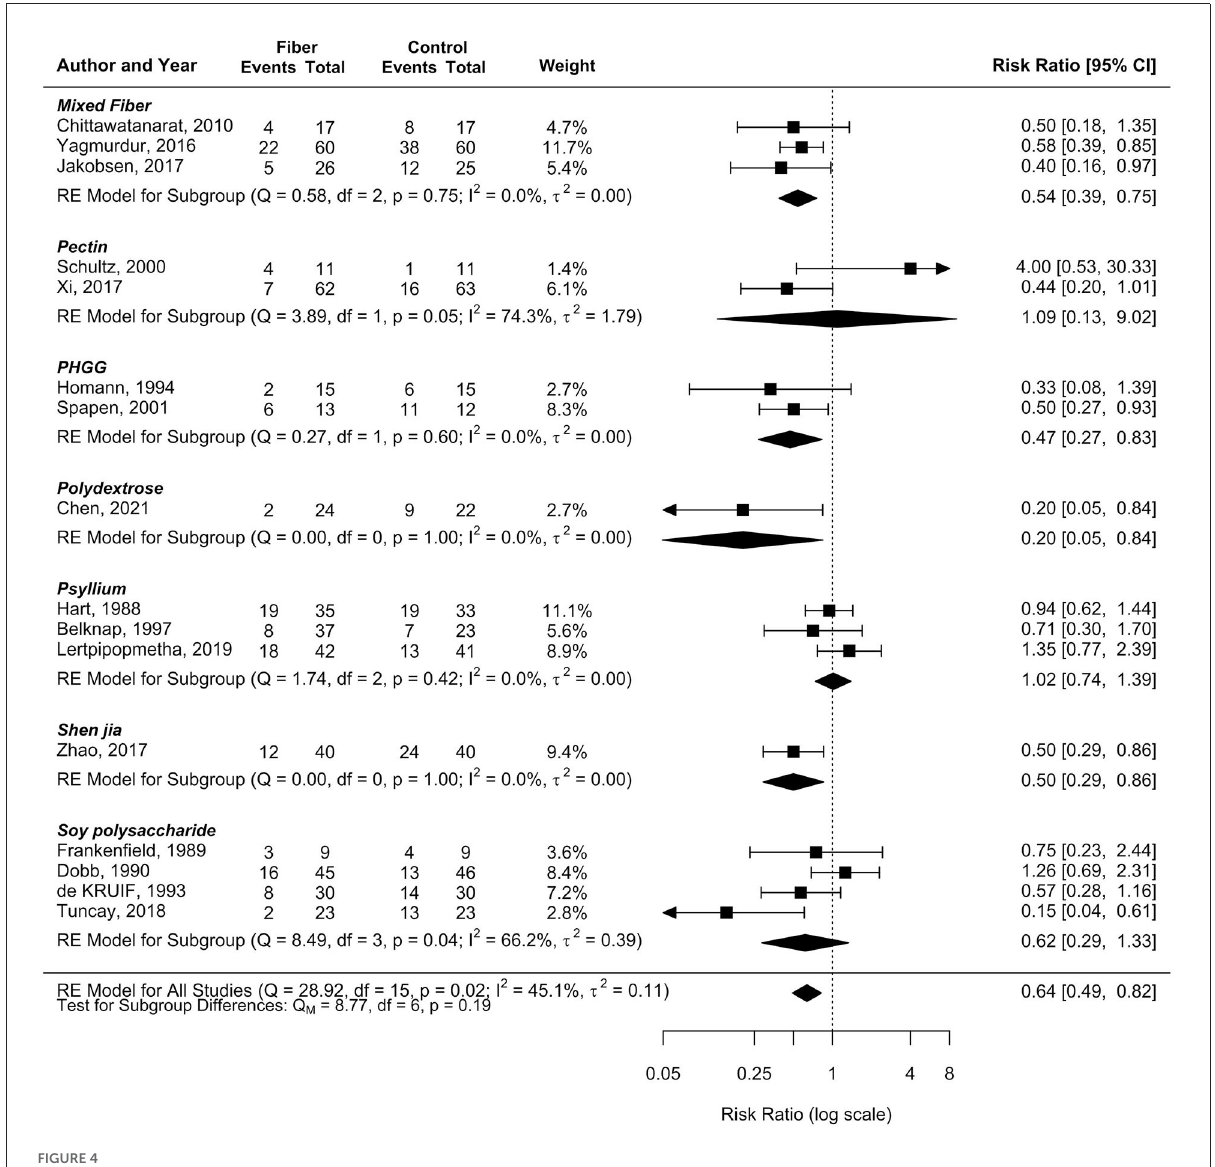
FIGURE4 Effect of fiber types in EN on the incidence of